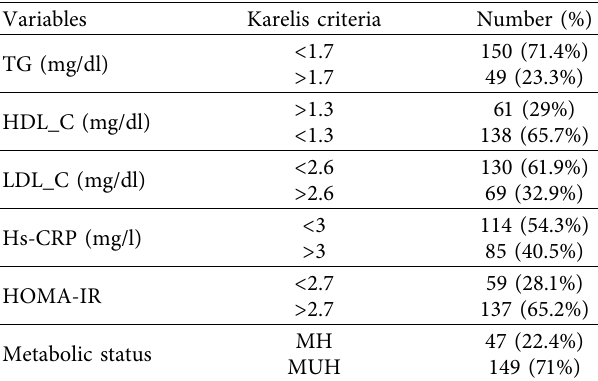
Table 1: Frequency of metabolic status based on Karelis criteria. Variables Karelis criteria Number